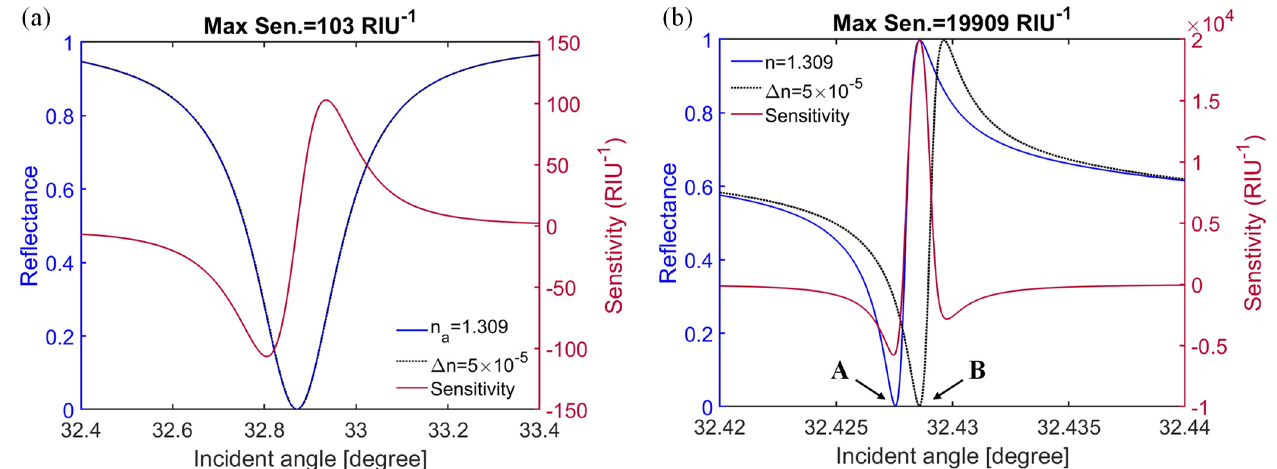
Figure 9. Variation of reflectance and sensitivity with the incident angle for ( a ) the 4 ‐ layer LRSPR based sensor and ( b ) the proposed 6 ‐ layer Fano resonance ‐ based sensor.